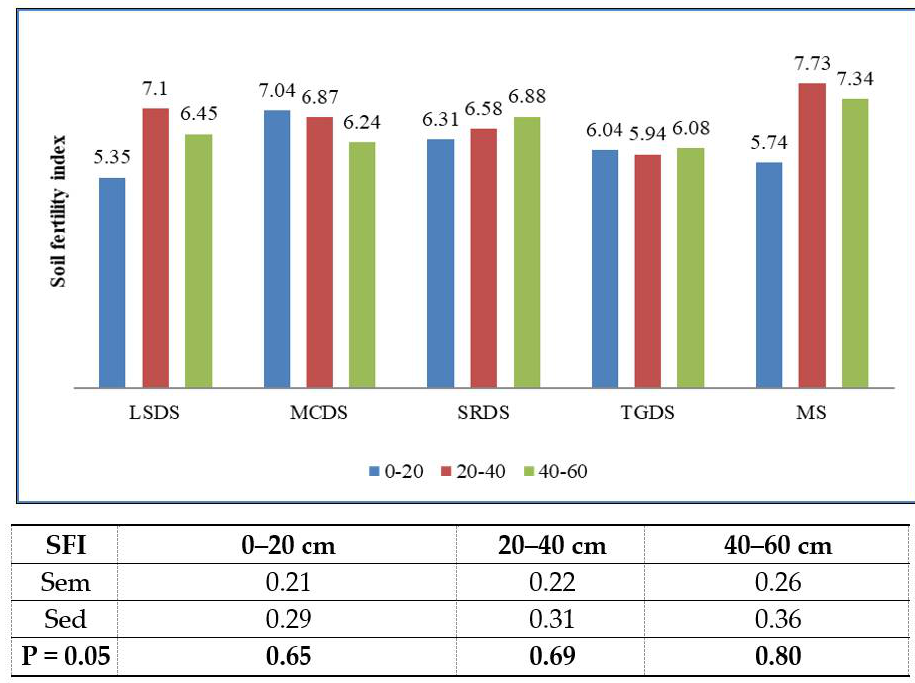
Figure 2. Soil fertility index of the stands at different soil depths.